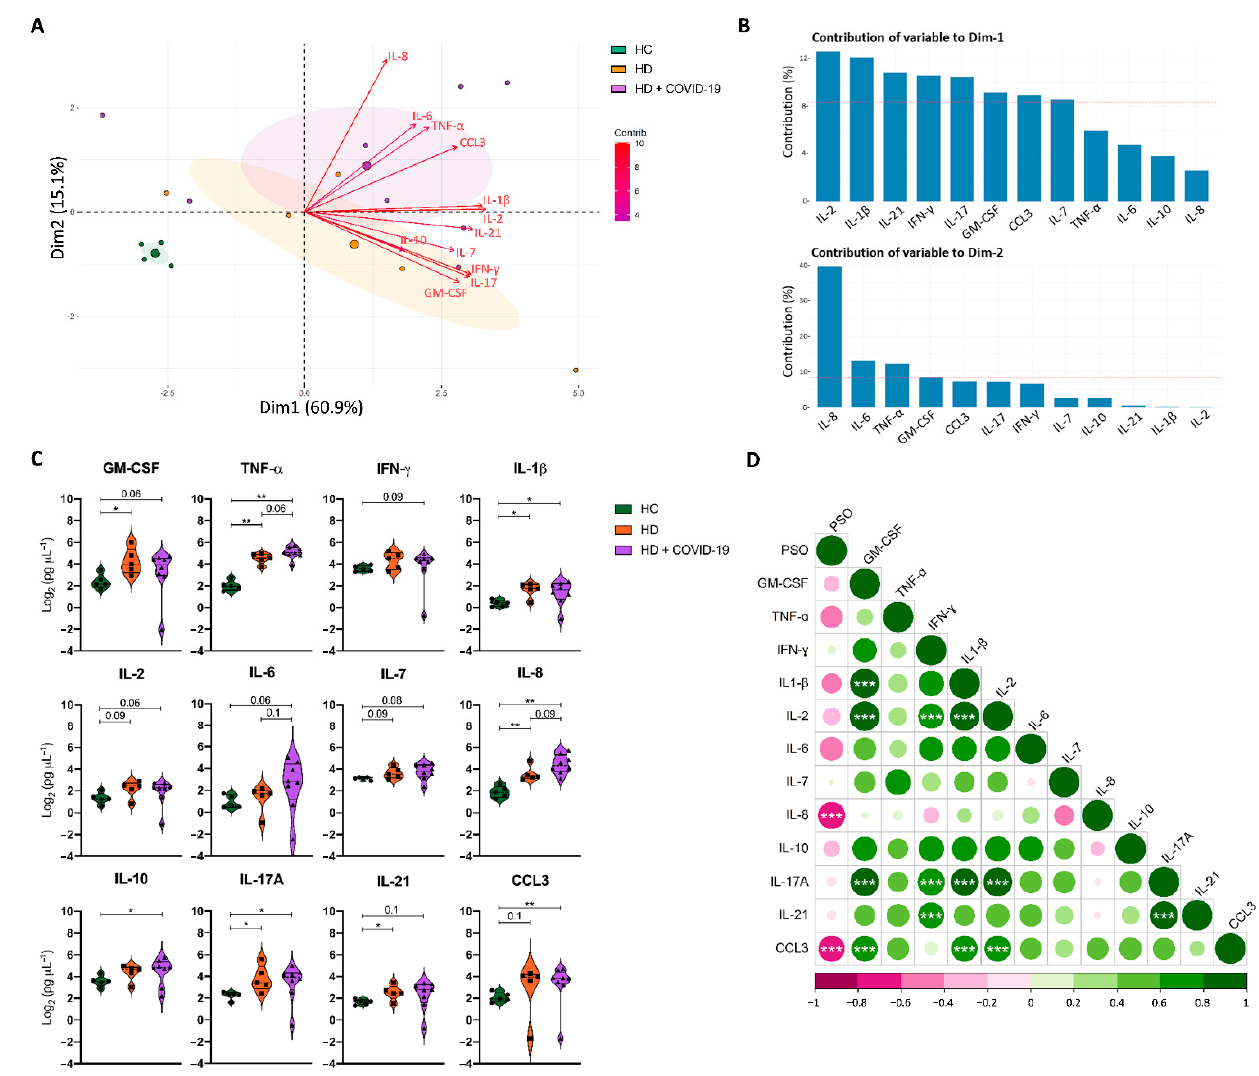
Figure 1. Differential cytokine profile in HC, HD and HD + COVID-19 patients. ( A ) Principal component analysis (PCA) of 12 cytokines in plasma from HC, HD and HD + COVID-19 patients shows an inflammatory cytokine profile in HD patients, further increased by SARS-CoV-2 infection. Each small dot represents a sample; large dots represent the median of the group and shaded area is the 95% confidence interval. ( B ) Contribution of each cytokine to PCA dimensions 1 and 2. Red dashed